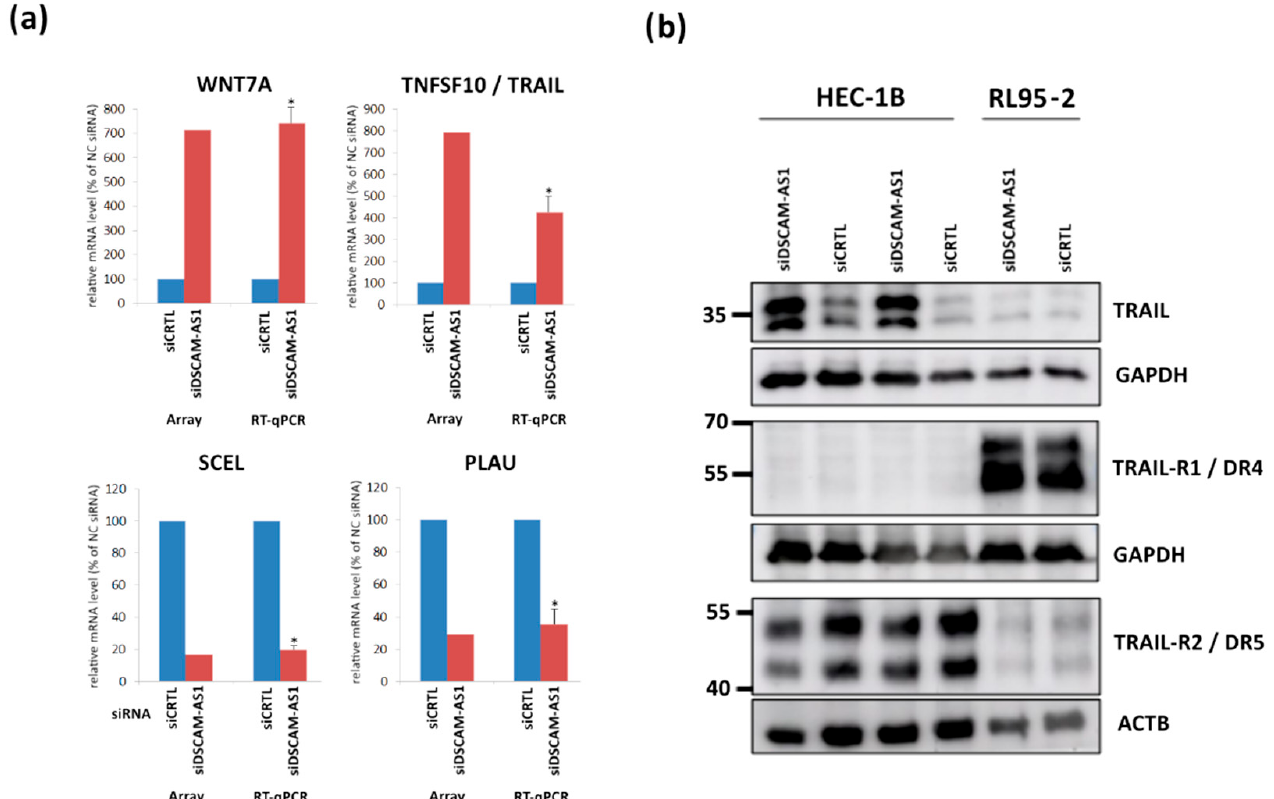
Figure 4. ( a ) Validation of the microarray results by analyzing expression of the indicated genes after DSCAM-AS1 knockdown by means of RT-qPCR comparing the results of both methods. Total RNA from cells transfected with negative control siRNA (siCTRL, NC) (AM4611, Thermo Fisher) was used as internal control. ( b ) Western blot analysis of TNFSF10 gene product TRAIL, significantly upregulated on the mRNA level in HEC-1B cells, and of TRAIL receptors DR4 and DR5. Shown are exemplary WB results. As loading controls, housekeeping genes GAPDH and ACTB were analyzed. * p < 0.01 vs. siCTRL.